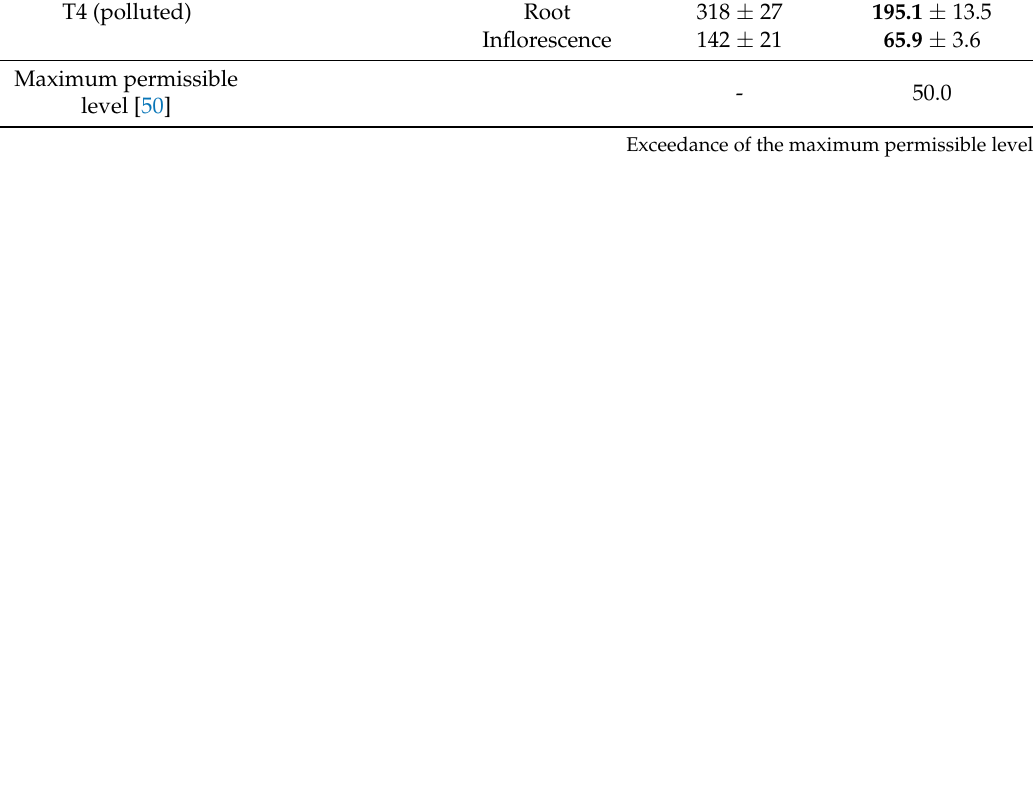
Exceedance of the maximum permissible level for grasses is typed in